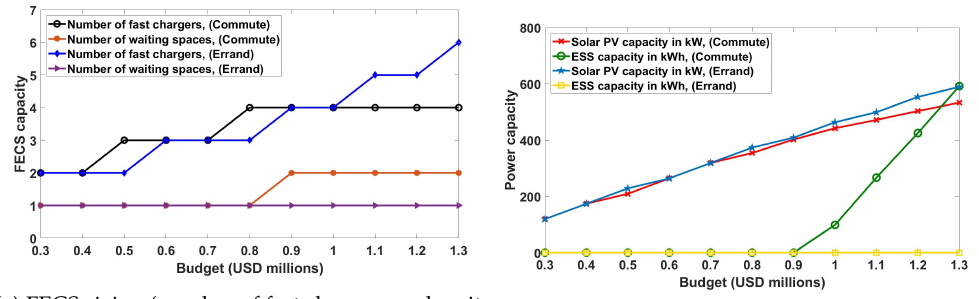
Figure 5. Optimal configuration of the FECS for the commute and errand distributions according to the budget.